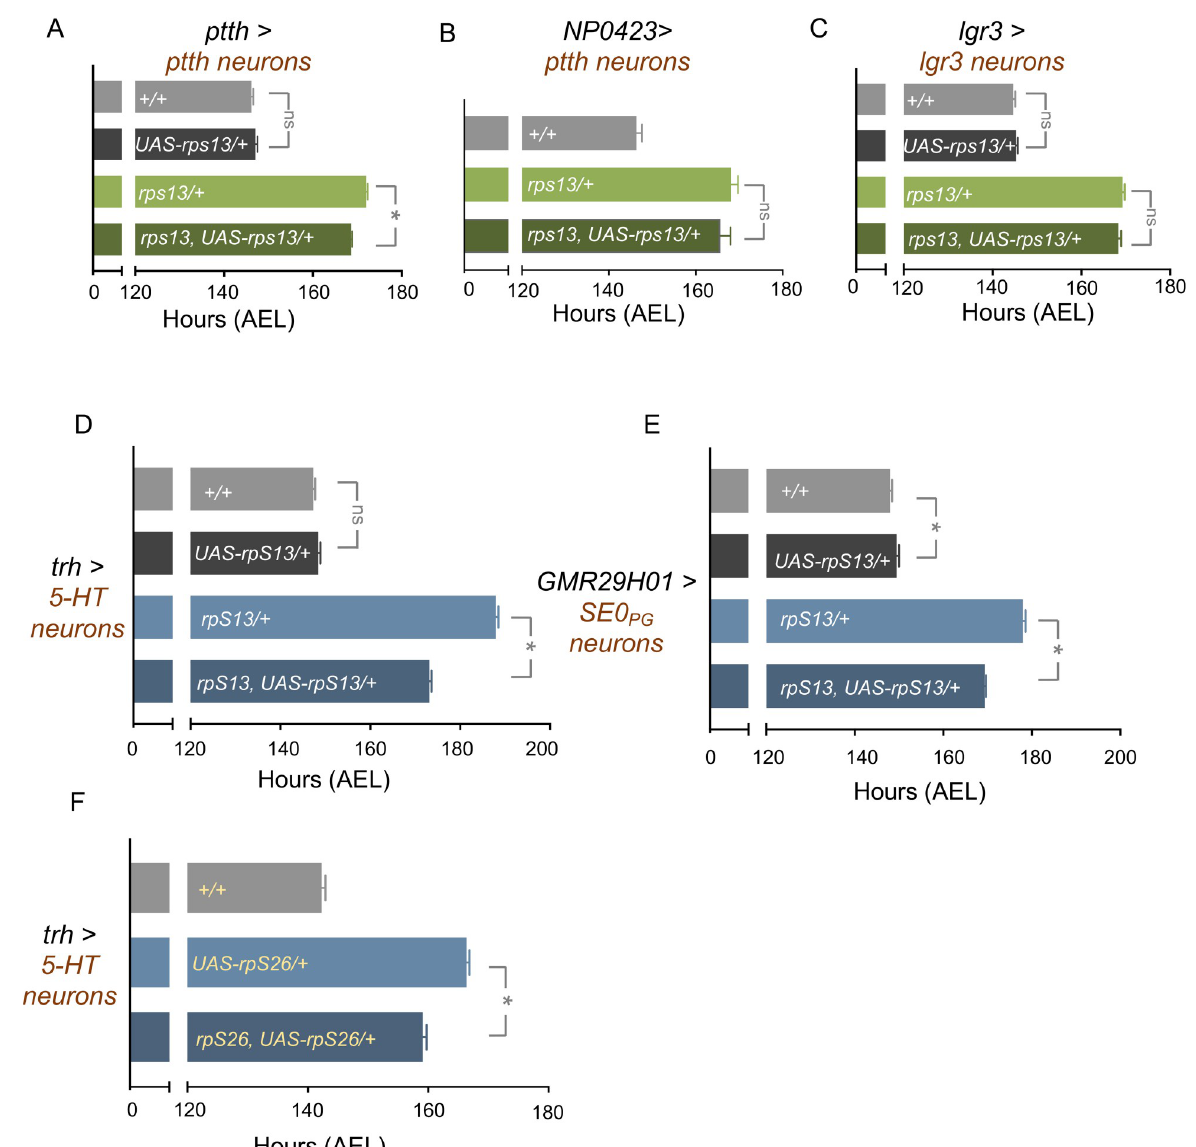
Fig 4. rpS13 re-expression in the serotonergic neurons that innervate the prothoracic gland partially rescues rpS13/+ developmental delay. (A) Time to pupation of +/+ and rpS13/+ larvae with or without UAS-rpS13 expression in the ptth neurons using ptth-Gal4 . Data are presented as +/- SEM. ns = not significant, � p < 0.05, Mann-Whitney U test. n = 233 ( +/ +), 288 ( UAS-rpS13/+ ), 282 ( rpS13/+ ), 282 ( rpS13 , UAS-rpS13/+ ). (B) Time to pupation of +/+ and rpS13/+ larvae with or without UAS-rpS13 expression in the ptth neurons using NP0423-Gal4 . Data are presented as +/- SEM. ns = not significant, � p < 0.05, Mann-Whitney U test. n = 127 ( +/ +), 81 ( rpS13/+ ), 84 ( rpS13 , UAS-rpS13/+ ). (C) Time to pupation of +/+ and rpS13/+ larvae with or without UAS-rpS13 expression in Lgr3-expressing neurons using lgr3-Gal . Data are presented as +/- SEM. ns = not significant, � p < 0.05, Mann-Whitney U test. n = 92 ( +/ +), 176 ( UAS-rpS13/+ ), 177 ( rpS13/+ ), 166 ( rpS13 , UAS-rpS13/+ ). (D) Time to pupation of +/+ and rpS13/+ larvae with or without UAS-rpS13 expression in serotonergic neurons using Trh-Gal4 . Data are presented as +/- SEM. ns = not significant, � p < 0.05, Mann-Whitney U test. n = 241 ( +/ +), 176 ( UAS-rpS13/+ ), 234 ( rpS13/+ ), 230 ( rpS13 , UAS-rpS13/+ ). (E) Time to pupation of +/+ and rpS13/+ larvae with or without UAS-rpS13 expression in SE0 PG serotonergic neurons using GMR29H01-Gal4 . Data are presented as +/- SEM. � p < 0.05, Mann-Whitney U test. n = 225 ( +/ +), 196 ( UAS-rpS13/+ ), 192 ( rpS13/+ ), 248 ( rpS13 , UAS-rpS13/+ ). (F) Time to pupation of +/+ larvae and rpS26/+ larvae with or without UAS-rpS26 expression in serotonergic neurons using Trh-Gal4 . Data are presented as +/- SEM. � p < 0.05, Mann-Whitney U test. n = 116 ( +/ +), 111 ( rpS26/+ ), 184 ( rpS26 , UAS-rps26/+ ).